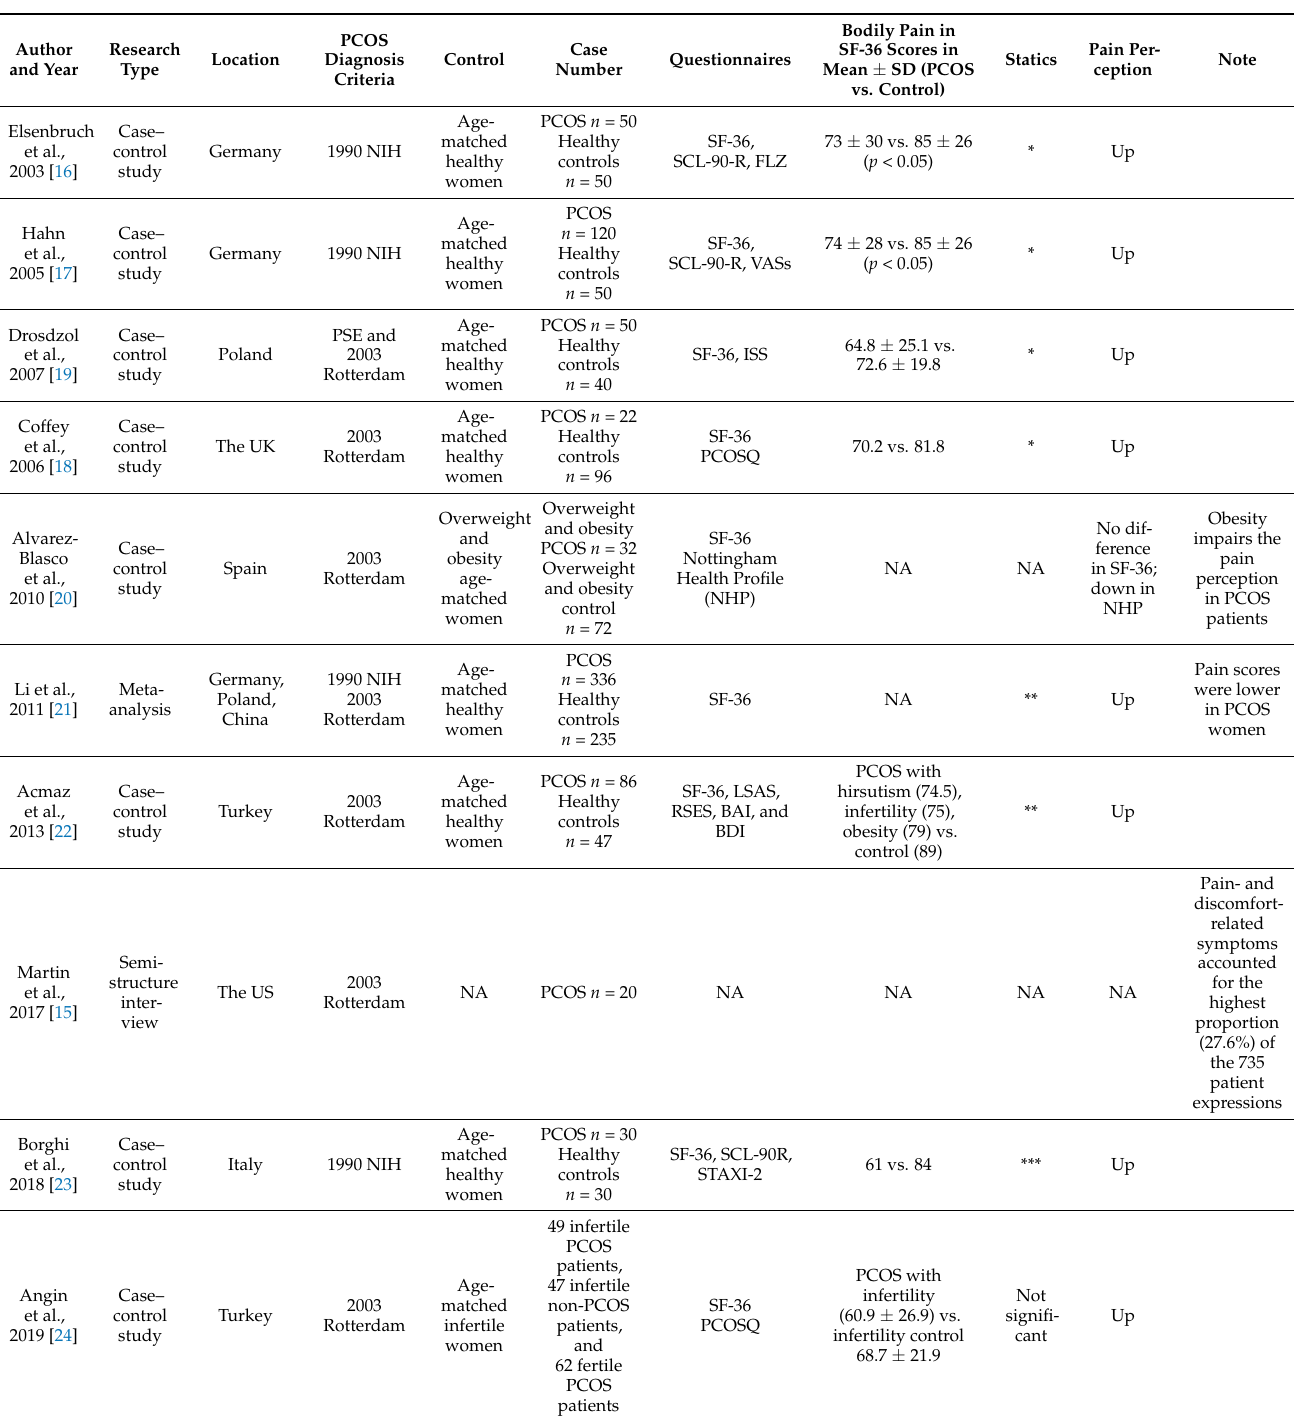
Table 1. PCOS-related HRQoL and pain perception